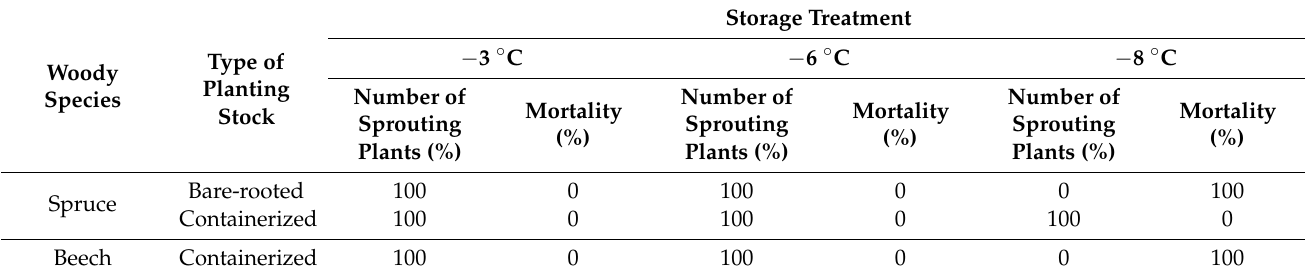
Table 2. The number of sprouting plants after planting and mortality at the end of the growing season planted to check plant viability during storage.